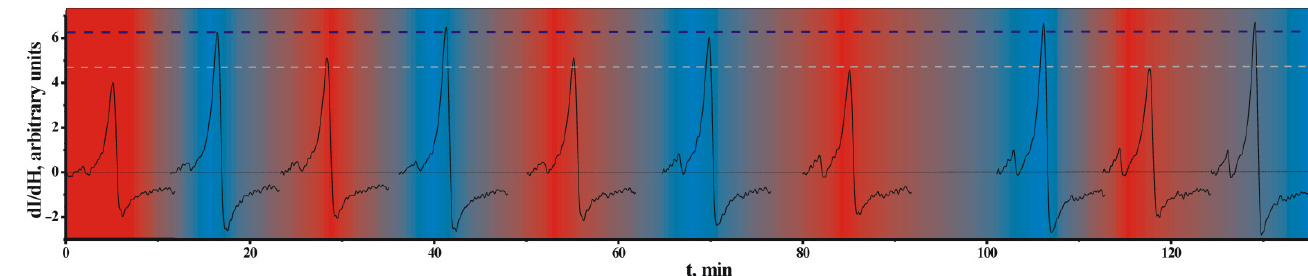
Figure 4. Time evolution of EPR line 1 recorded at 100 K in frozen solution freely oscillating during BZ reaction at 295 K. Background colors correspond to the colors of the solution at the moment of its freezing. Horizontal dashed lines correspond to minimal and maximal amplitudes of EPR lines during oscillation.